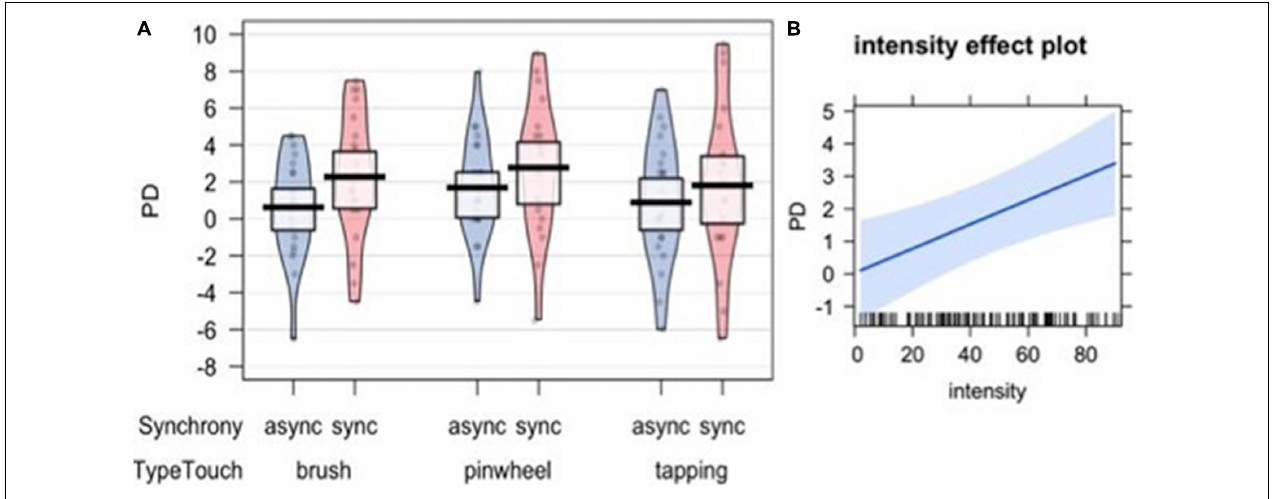
FIGURE 7 | Proprioceptive Drift (PD) measuring the shift in the localization of participants’ own hand after the visuo-tactile induction of the illusion (A) . The right panel represents the effect of subjective intensity in driving the PD (B) . TABLE 1 | Descriptive statistics for each type of visual-tactile stimulation (mean and standard deviation of the PD) and simple t -test comparing the PD scores with the null level. Type of visual-tactile stimulation Brush Brush Pinwheel Pinwheel Tapping Tapping sync async sync async sync